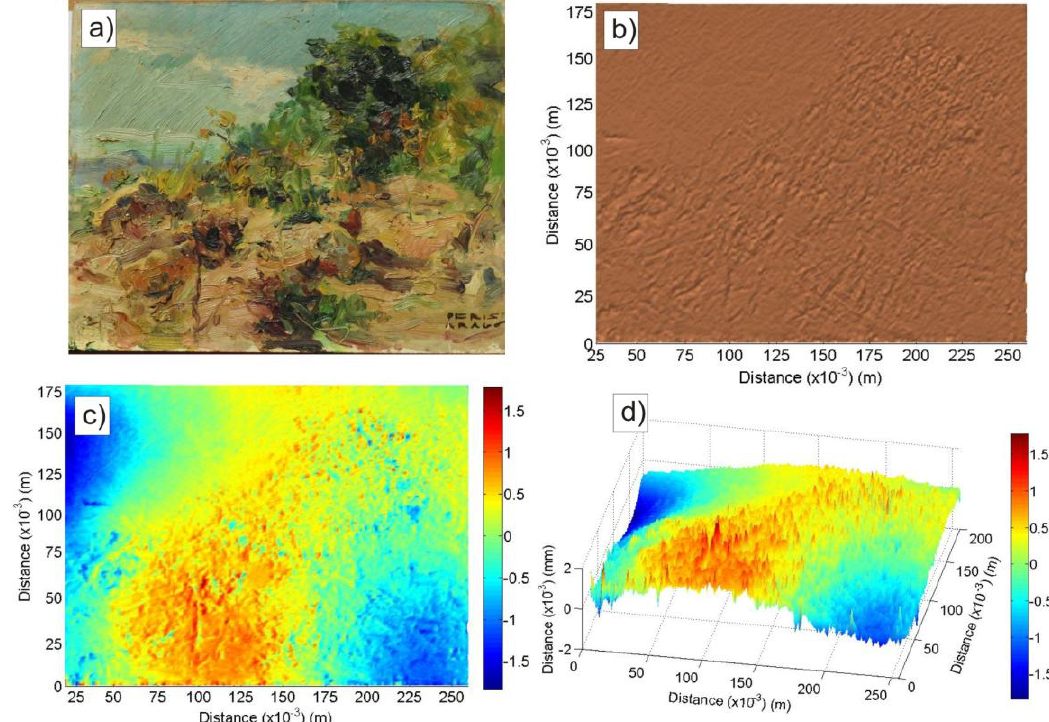
Figure 3. ( a ) Photograph of the panel painting used to check the PSA method presented in this work; ( b – d ) Photogrammetric scanning image results: ( b ) monochrome two-dimensional view; ( c ) two-dimensional and ( d ) three-dimensional views with colour scale where the relative height of the brushstrokes is